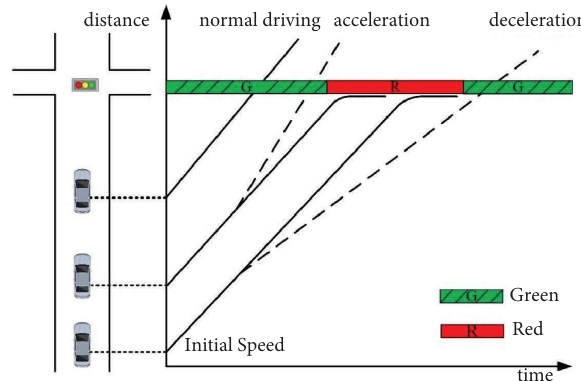
Figure 1: Te schematic diagram of CAV guidance at an